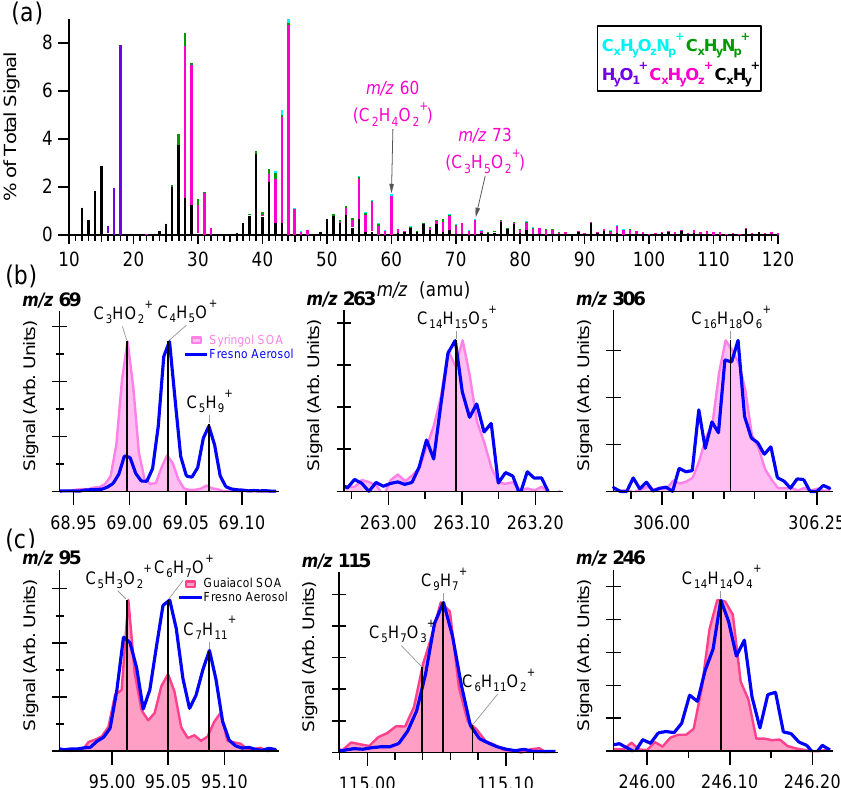
Fig. 9. (a) Categorized HRMS of Fresno aerosol collected on 9 January 2006 after a fog event (H 2 O + = CO + on Sun et al., 2010); (b) and (c) comparison of AMS raw mass spectra of selected m/z ’s between Fresno aerosol and aqueous phase SOA produced from syringol and guaiacol,